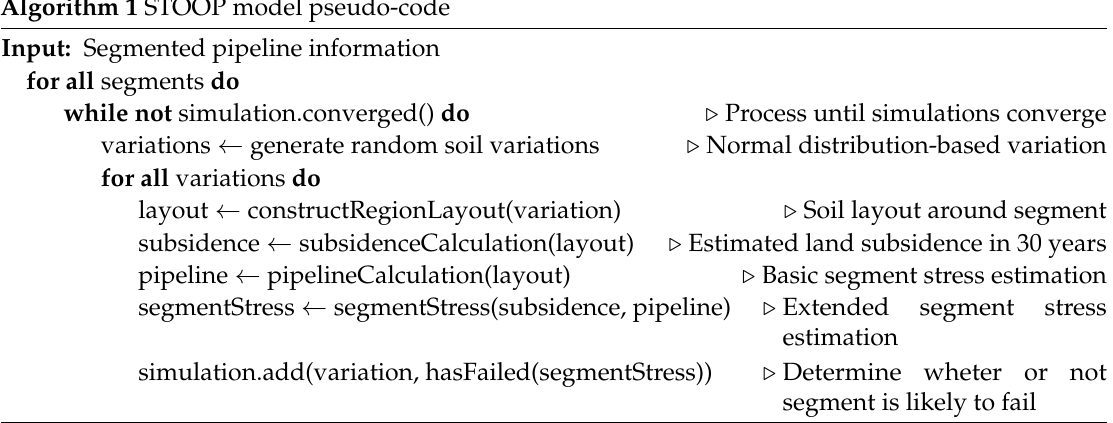
Algorithm 1 STOOP model